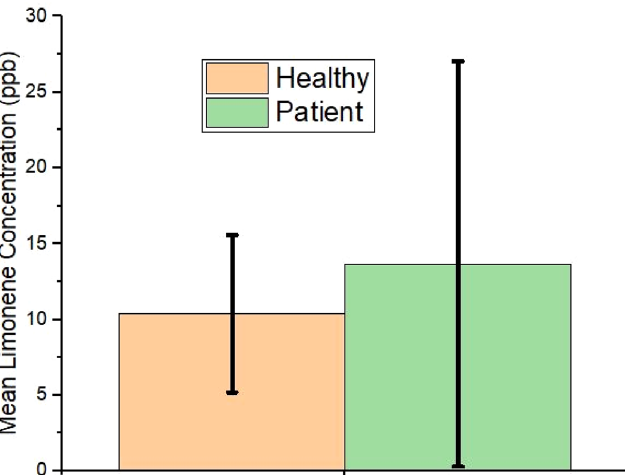
Figure 5. Mean limonene concentration (ppb) difference from collected exhaled breath of patient and healthy